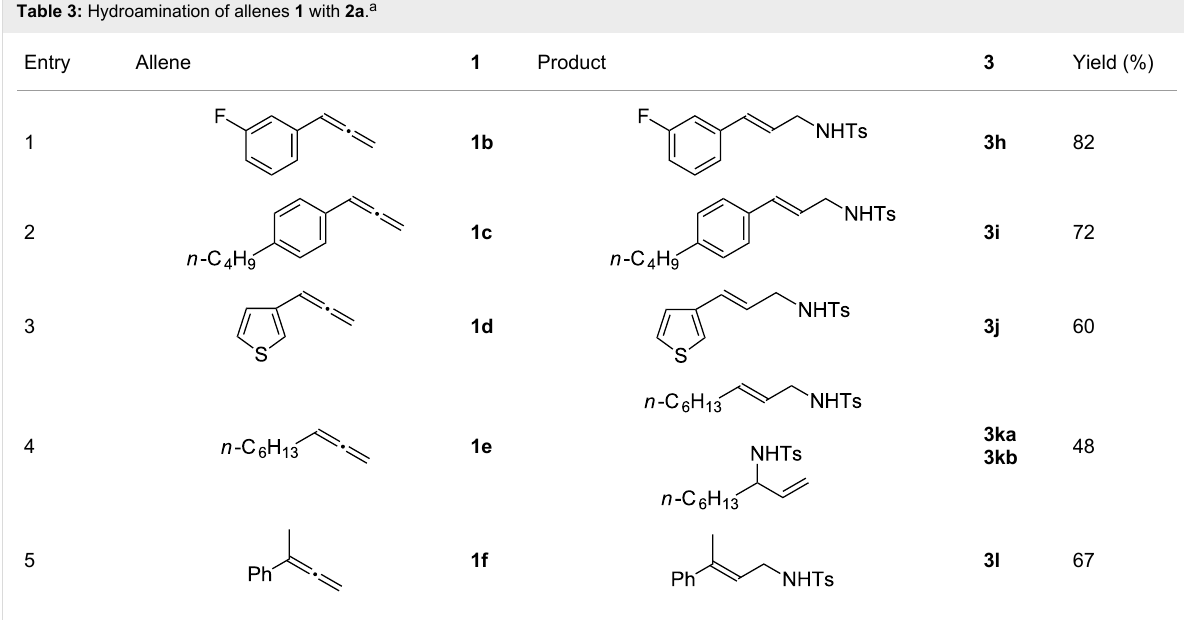
Table 3: Hydroamination of allenes 1 with 2a .